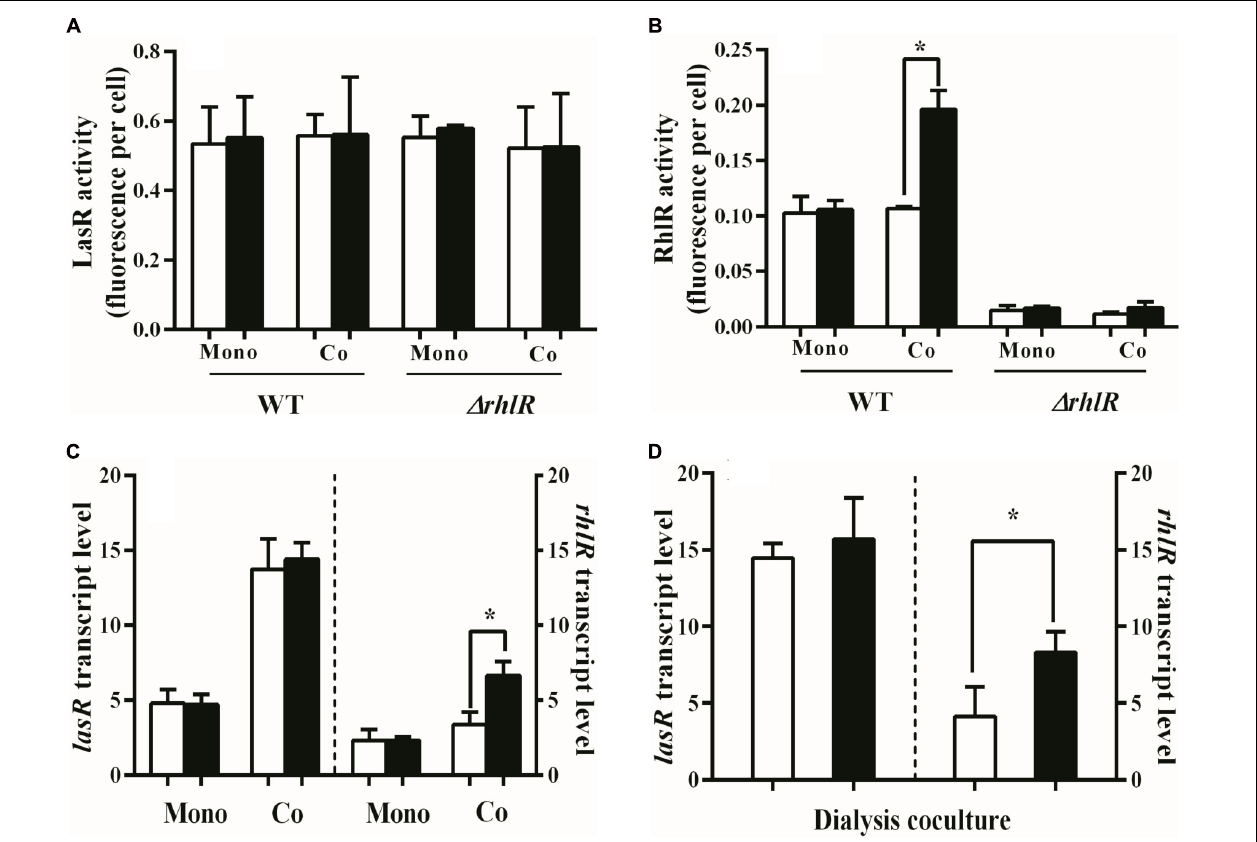
FIGURE 2 | LasR and RhlR activities in w.t. P. aeruginosa . (A) GFP transcription in w.t. containing the lasI–gfp reporter plasmid pBS351. GFP is a proxy for LasR activity. Added ammonium sulfate does not alter the LasR activity of cooperators in w.t or a RhlR mutant, either in the presence or absence of cheaters. (B) GFP transcription in w.t. using the rhlA–gfp reporter plasmid pJF01. Addition of ammonium sulfate significantly increased the RhlR activity of cooperators in presence of cheaters. A RhlR mutant is shown as a reference. (C) Transcription of lasR and rhlR measured by qRT-PCR. Added ammonium sulfate significantly increased the transcript levels of rhlR but not lasR in the presence of cheaters. (D) Added ammonium sulfate significantly increased the expression of rhlR in the presence of LasR-mutant cheaters. The w.t. and LasR mutants were separated by a dialysis membrane. “Mono”: monoculture of w.t. or the RhlR mutant. “Co”: co-culture with 9:1 mixture of w.t and LasR mutants or a mixture of RhlR mutants and LasR mutants. We used proC as a reference (housekeeping) gene. White bars indicate PM-casein without ammonium sulfate and black bars indicate PM-casein with ammonium sulfate. Experiments were performed in triplicate. Data reported as the mean ± SD. ∗ indicates p < 0.05 by paired Student’s t